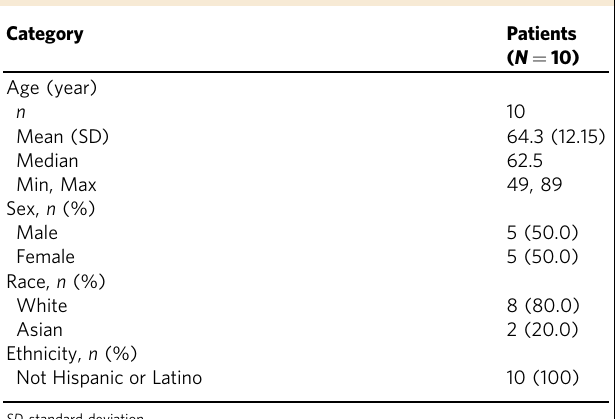
Table 1 Demographic characteristics of the enrolled